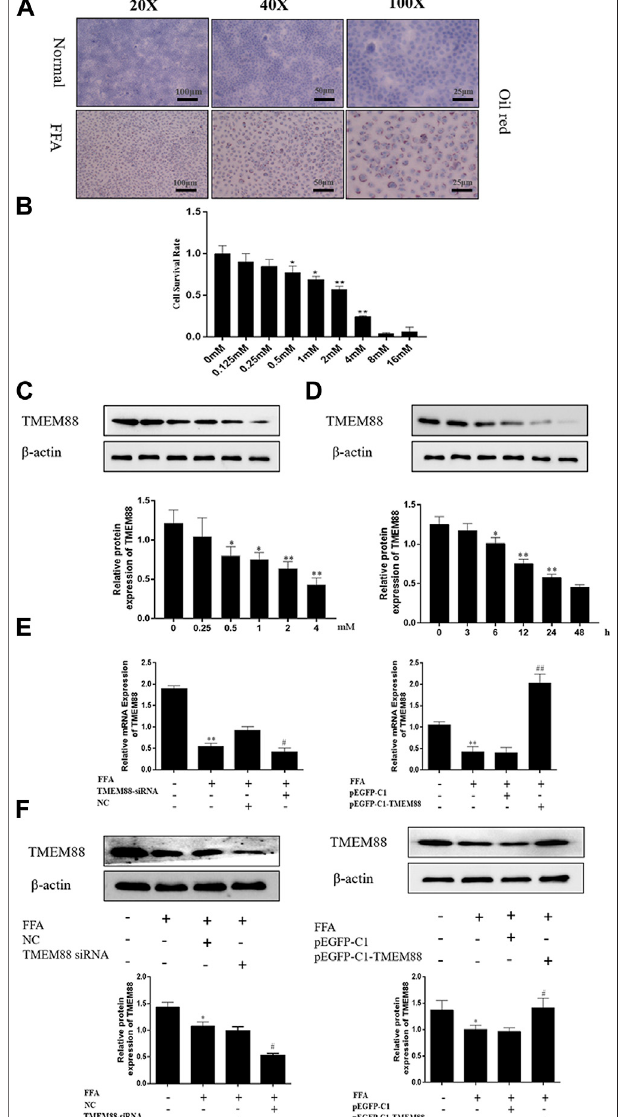
FIGURE 3 | FFA inhibited TMEM88 expression in AML-12 cells. (A) The oil red stains in AML-12 cells and FFA-induced AML-12 cells. The results showed that fat granules appear in the FFA-induced cell model. (B) Viability of AML-12 cells at different FFA concentrations. (C) TMEM88 protein expression level was signi fi cantly reduced, after being induced with 2 mM FFA. (D) A signi fi cant reduction of the expression level of TMEM88 protein was signi fi cantly reduced after FFA was stimulated with 24 h. (E) TMEM88 mRNA expression levels in FFA-induced AML-12 cells after pEGFP-C1-TMEM88 and TMEM88 siRNA transfection. (F) TMEM88 protein expression levels in FFA-induced AML-12 cells after transfected with pEGFP-C1-TMEM88 and TMEM88 siRNA. (The data are represented by at least three independent mean ± SD, * p < 0.05, ** p < 0.01 vs normal group. # p < 0.05, ## p < 0.01 vs control transfected with the TMEM88siRNA or pEGFP-C1-TMEM88. The results indicated that upregulation of TMEM88 inhibited the expression levels of SREBP-1c and FASN and upregulated PPAR-